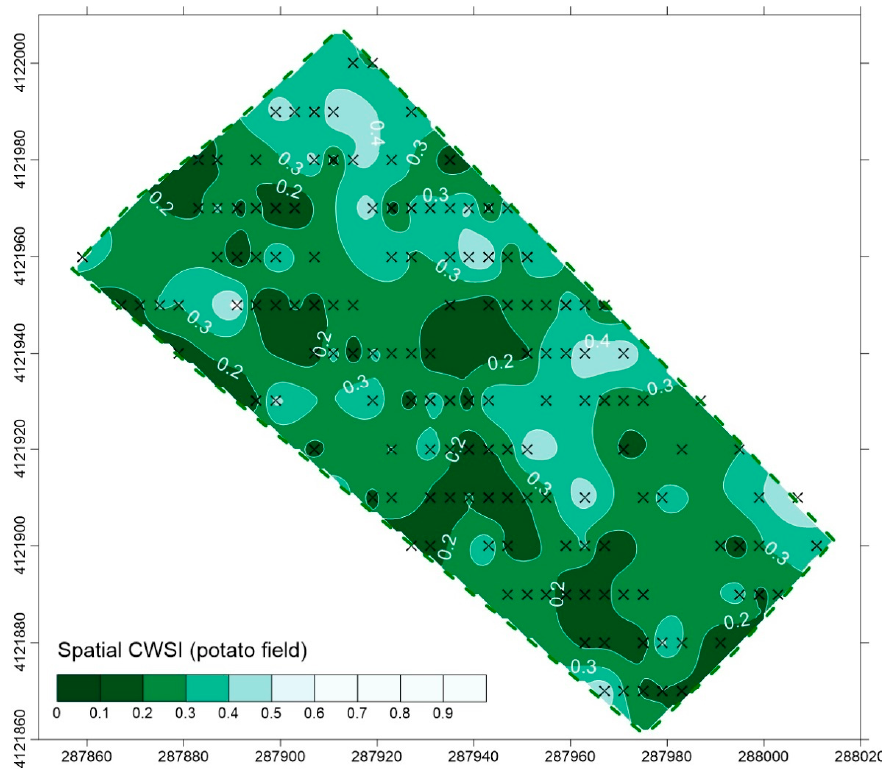
Figure 18. Spatial estimates (isolines of CWSI) from the first pilot flight with AMMS.